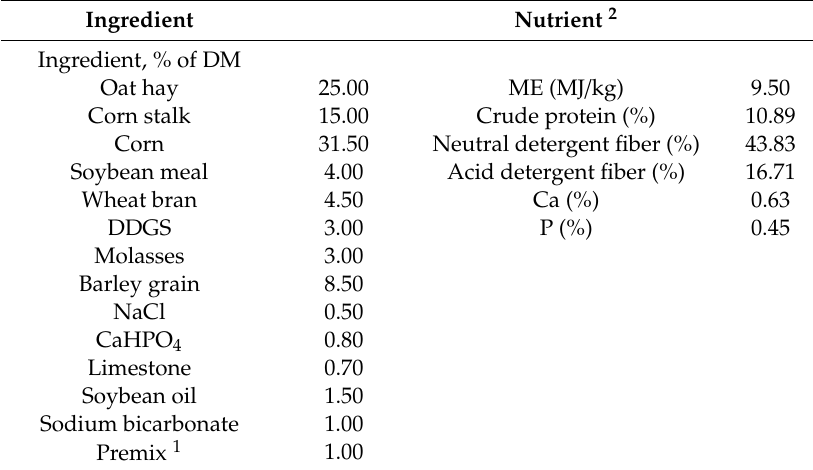
Table 1. Ingredient and nutrient levels of the diet o ff ered the lambs in Experiments 1 and 2. Ingredient Nutrient 2 Ingredient, % of DM Oat hay